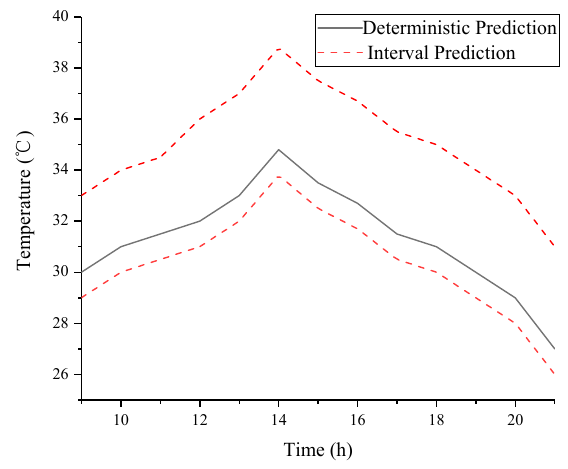
Figure 2. The forecasting of air temperature.